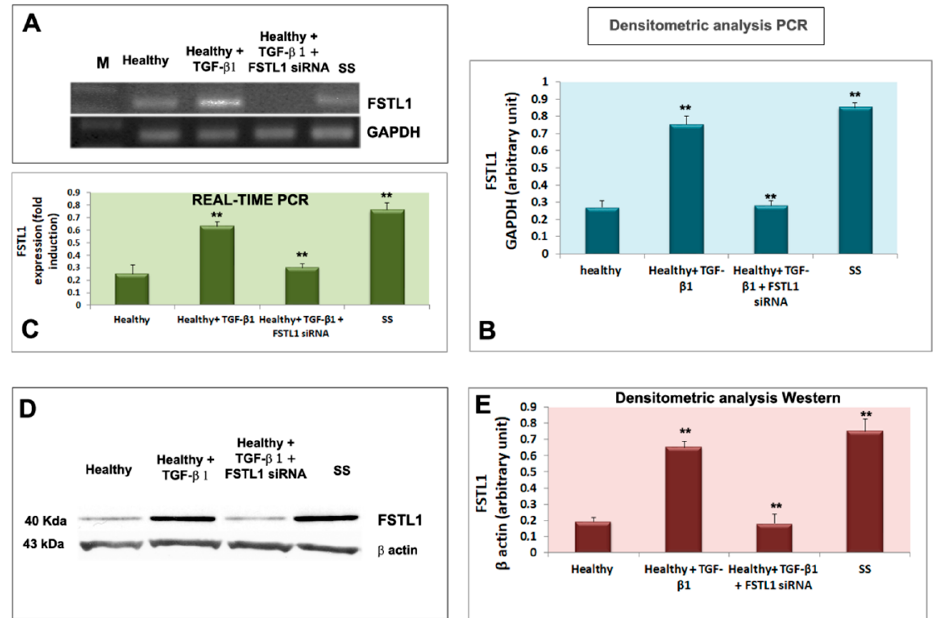
Figure 2. TGF- β 1 treatment resulted in the upregulation of FSTL1 expression in healthy SGEC treated with TGF- β 1. ( A , B ) show that the TGF- β 1 treatment resulted in the upregulation of FSTL1 mRNA expression compared to untreated cells, with GAPDH as a reference gene. Quantitative Real-Time PCR confirmed this result ( C ). Normalized gene expression levels were given as the ratio between the mean value for the target gene and that for the β -2 microglobulin. PCR reactions were performed in triplicate and the data were presented as fold changes in gene expression (mean ± SE of three independent experiments). FSTL1 protein expression was significantly induced by TGF- β 1 treatment as demonstrated by immunoblotting ( D , E ); (** = p < 0.01).